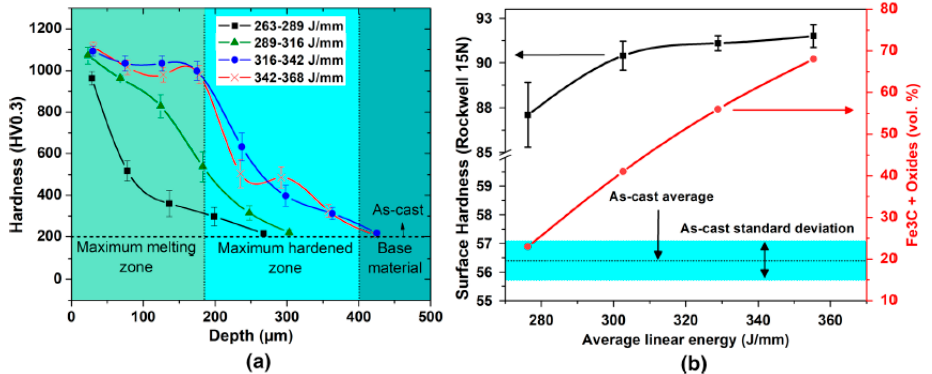
Figure 17. ( a ) Evolution of microhardness as a function of depth and linear energy. ( b ) Surface hardness and composition of as-cast and laser modified DIs (Reprinted with permission from ref. [69]. 2021 Springer Nature B.V.).